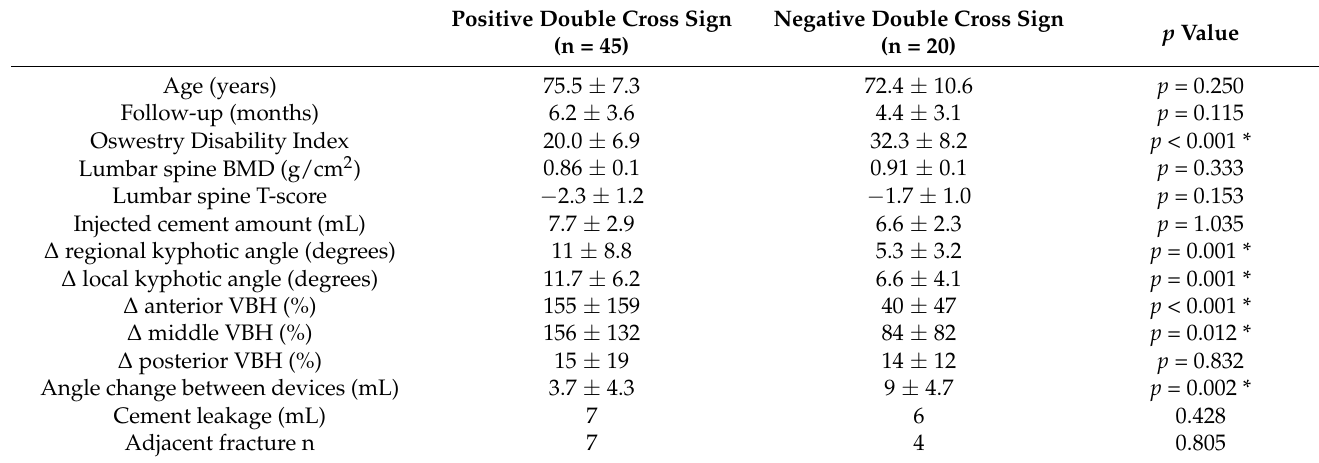
Table 2. Operative characteristics of patients with and without the double cross